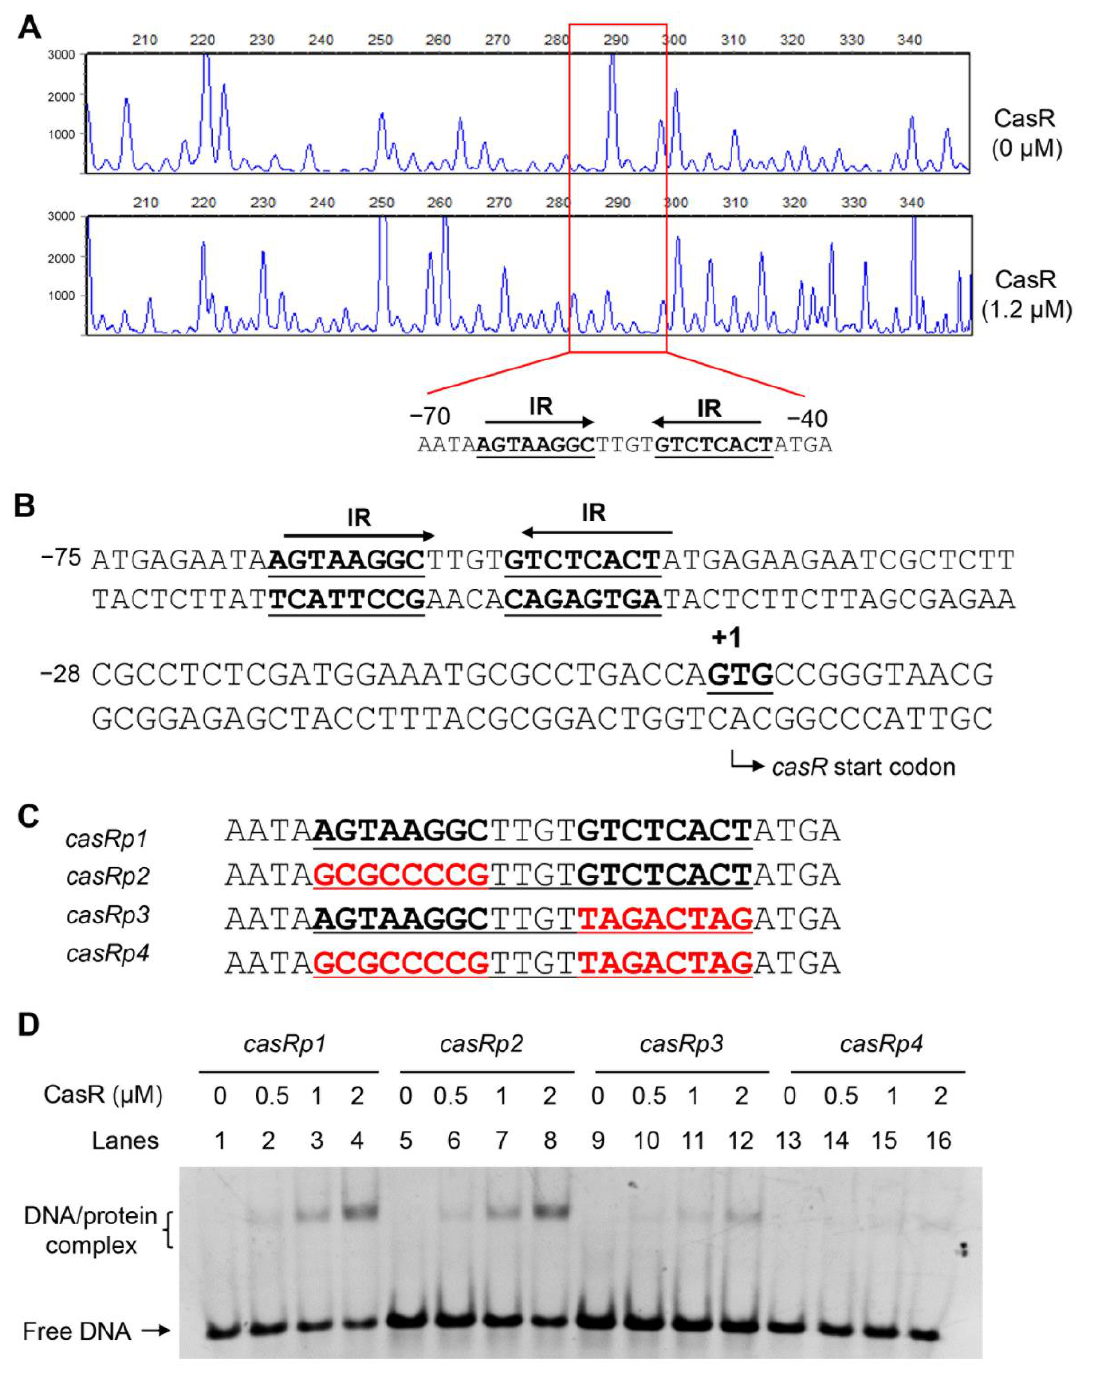
Figure 4. Profile of motif sequence recognized by CasR. ( A ) DNase I footprinting assay. The protective effect of CasR on the promoter DNA against DNase I digestion increased with increasing concentrations of CasR (0 μM, 1.2 μM). The sequences in the protected regions on the coding strand are underlined in the figures. ( B ) Sequence and structural characteristics of the promoter region protected by CasR. The regions protected by CasR are indicated with underlines, and the box indicates the 20 bp sequences containing two inverted repeats (IRs) with a 4 bp interval. The translation start codon of CasR is indicated in bold. ( C ) EMSA of DNA sequences with different mutations. Three mutant DNA probes contain left part mutation, right part mutation, and complete mutation of palindromic structure. ( D ) EMSA of four mutant DNA probes, with or without the IR sequence. Each DNA probe was co-incubated with 0 –2 μM Cas R protein.